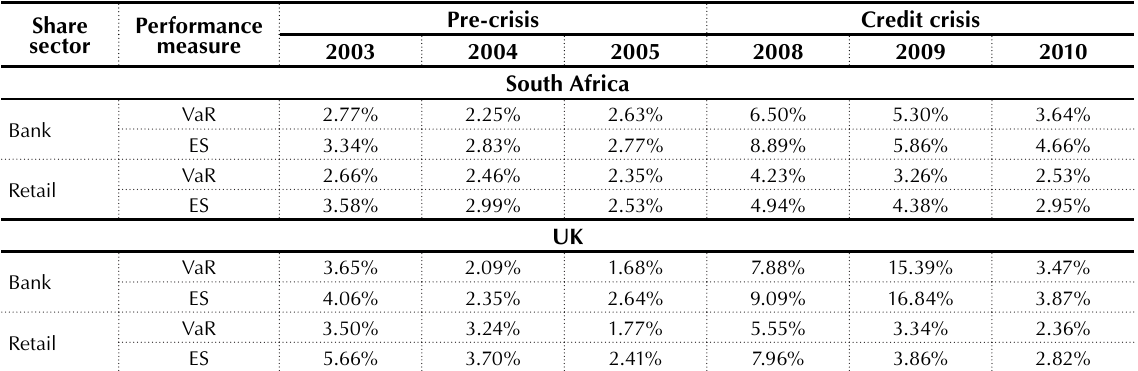
Table 6. Variance-covariance method results of 99% VaR and ES (daily returns)